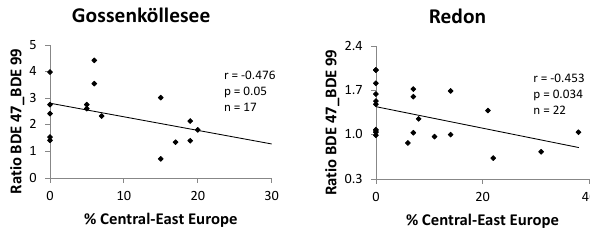
Fig. 8. Relationship between BDE47/BDE99 ratios and air mass trajectories flowing from central–eastern Europe in Gossenköllesee and